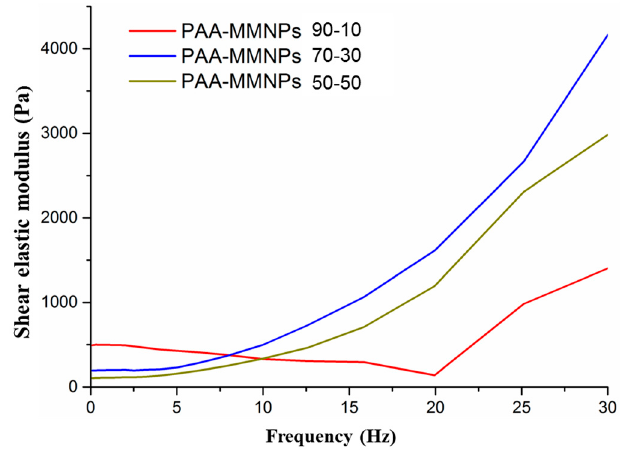
Figure 6. Elastic modulus G’ versus frequency .